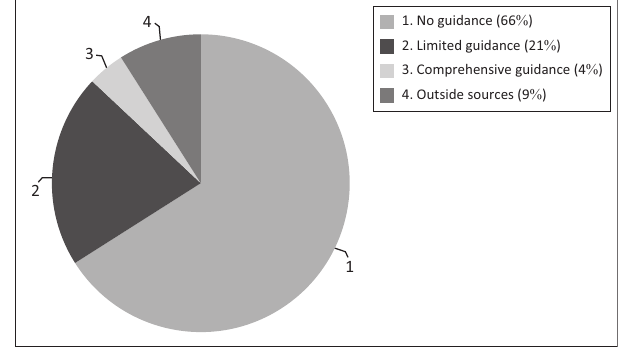
FIGURE 4: Reasons for not implementing an internal capital adequacy assessment process.